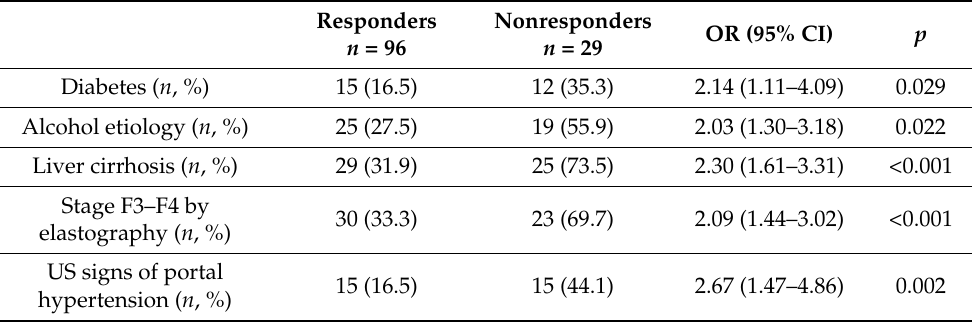
Table 3. Comparison of patient characteristics between responders and nonresponders to HBV vaccination by univariate analysis at six months.